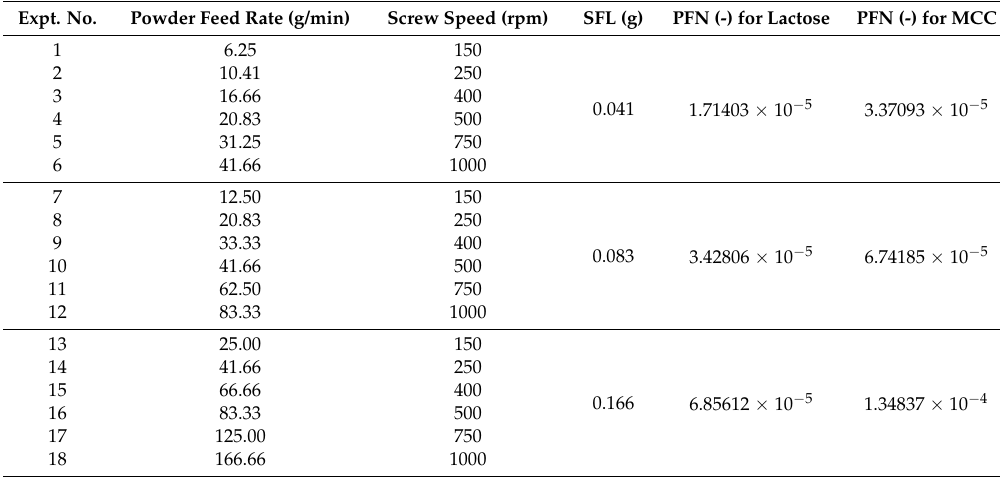
Table 1. Experimental plan. SFL—specific feed load; PFN—powder feed number; MCC— microcrystalline